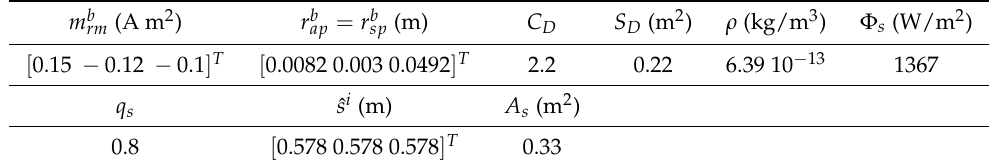
Table 3. Disturbance torques